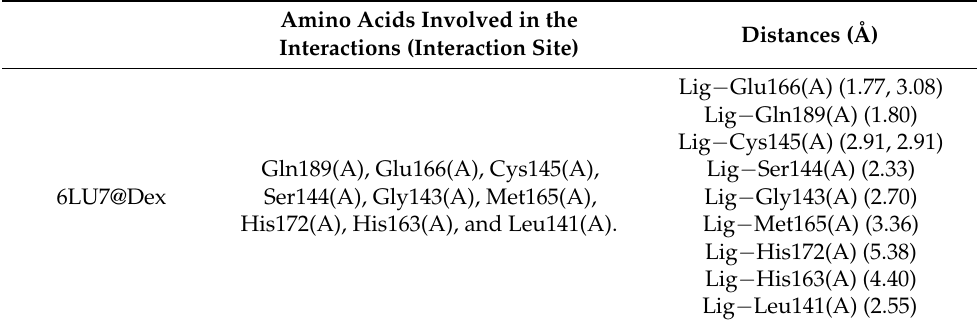
Figure 4. 3D visual representations of the interactions of Dex with the 6LU7 protein ( a ) best binding mode in the protein pocket; ( b , c ) amino acid residues involved in the interaction. Table 4. Amino acid contributions in the interactions of Dex with the 6LU7